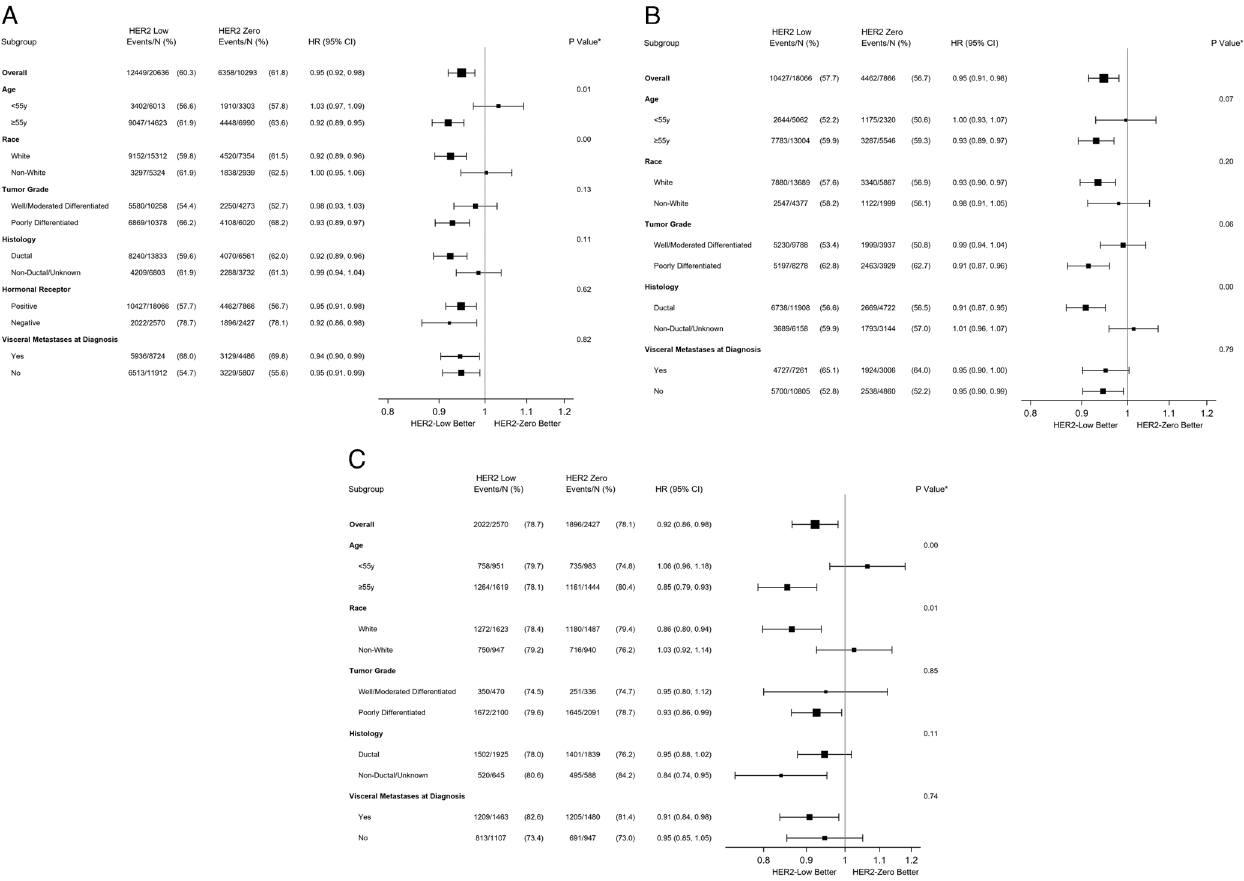
Fig. 4 Adjusted hazard ratio (HER2-low vs. HER2-zero breast cancer) from multivariable Cox regression analysis for overall survival. A All breast cancer; B HR + breast cancer. C HR − Breast cancer. p -value is calculated for interaction between HER2 expression level and each subgroup, based on using multivariable cox regression. Error bars showed the con fi dence interval of the hazard ratio of OS between HER2-low vs. HER2-zero breast cancer. The Cox regression models were adjusted for age, race/ethnicity, household income, comorbidities, location, tumor grade, histology, hormonal receptor status (if applicable), presence of visceral metastasis, the type of cancer center (where women received care), year of diagnosis, and treatment